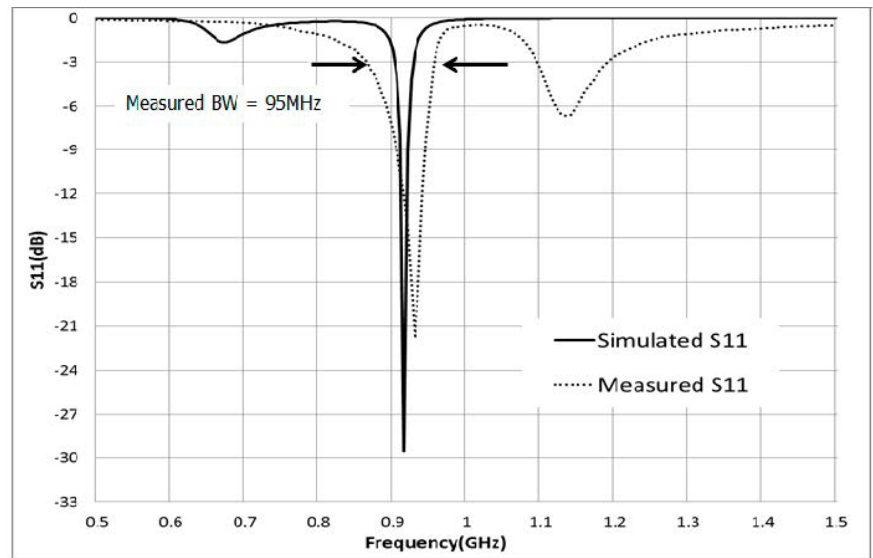
Figure 7. Simulated and measured S11 of tag antenna.